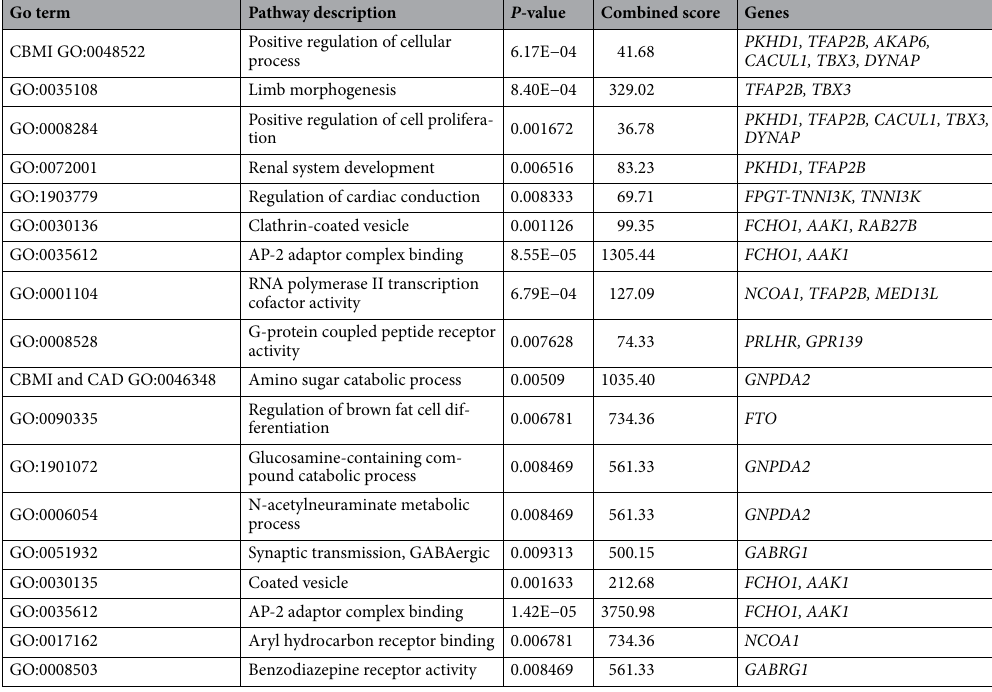
Table 3. Gene functional annotation and enrichment